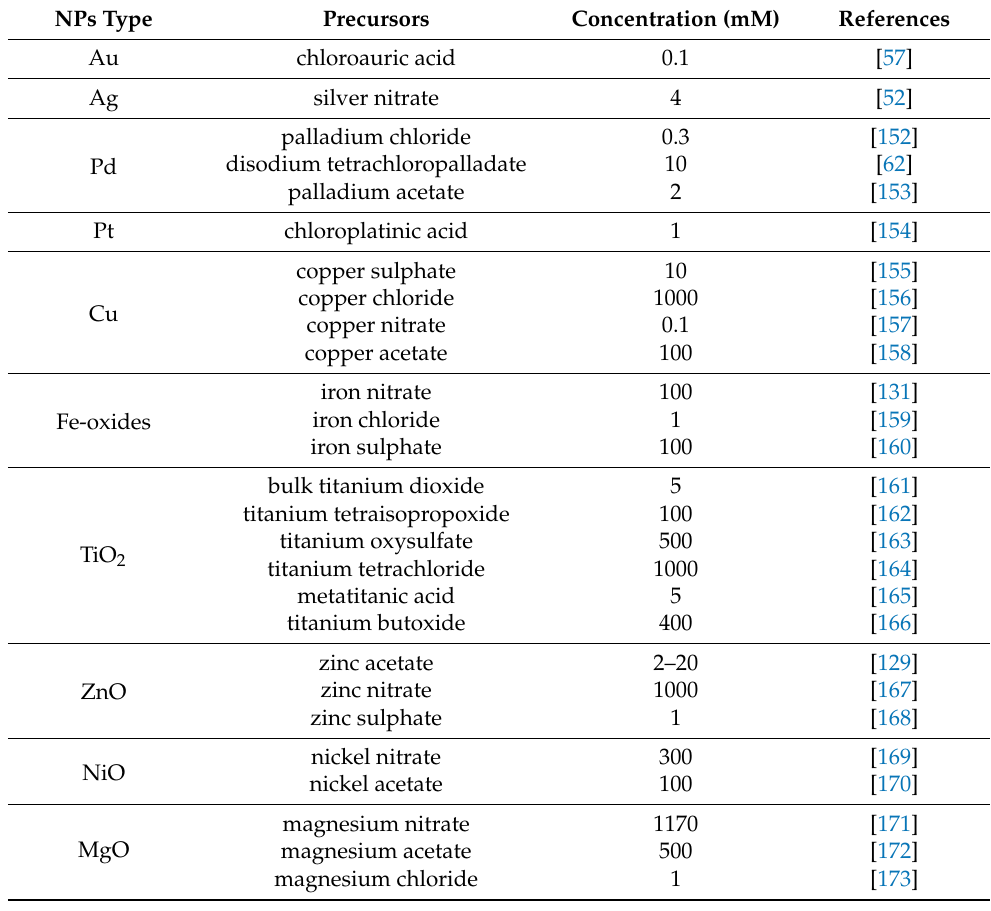
Table 2. Different precursors for green synthesized